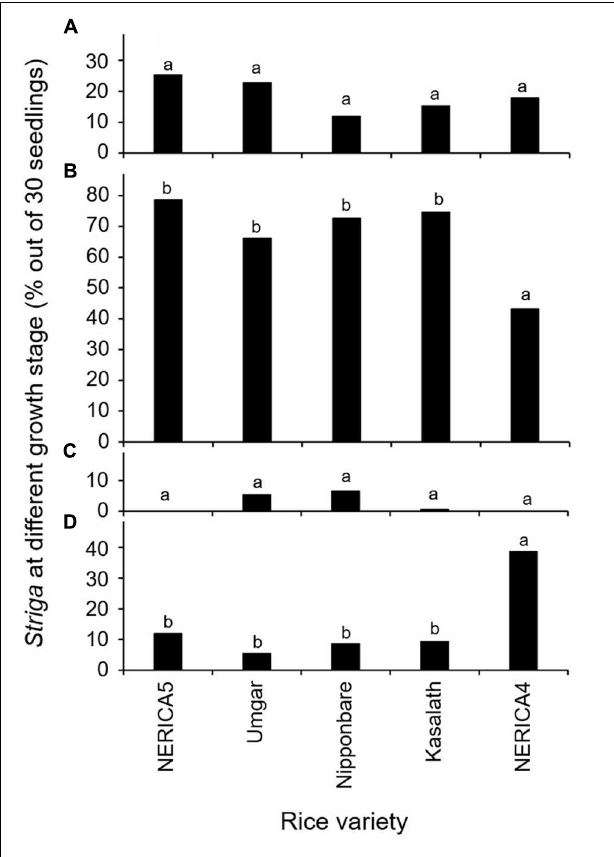
FIGURE 3 | Percentage out of 30 seedlings of S. hermonthica at stage (A) I, failure to attach to the root due to a lack of haustorium formation (Figure 1a); (B) II, successful attachment but no shoot elongation (Figures 1b–d); (C) III, shoot necrosis after reaching the four or more leaf pairs stage (Figures 1e,f); and (D) IV, successful parasitism with healthy shoots (Figures 1g,h) on the roots of five rice varieties in the second rhizotron experiment at 21 DAI. Means followed by a common letter are not significantly different by Tukey’s HSD test in each growth stage ( p <